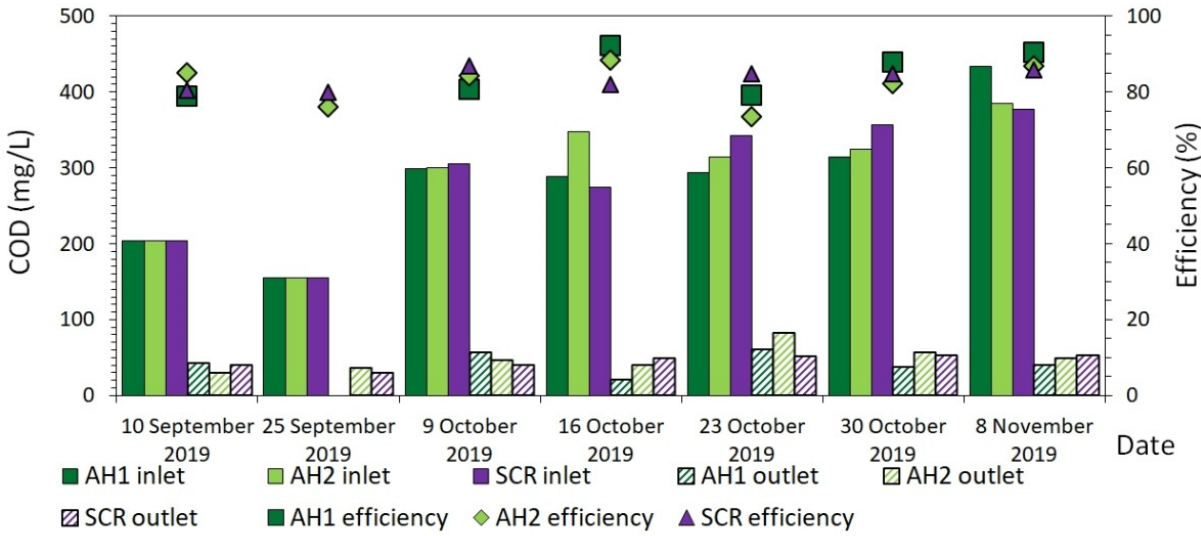
Figure 4. Inlet and outlet COD and removal efficiencies at stage I.